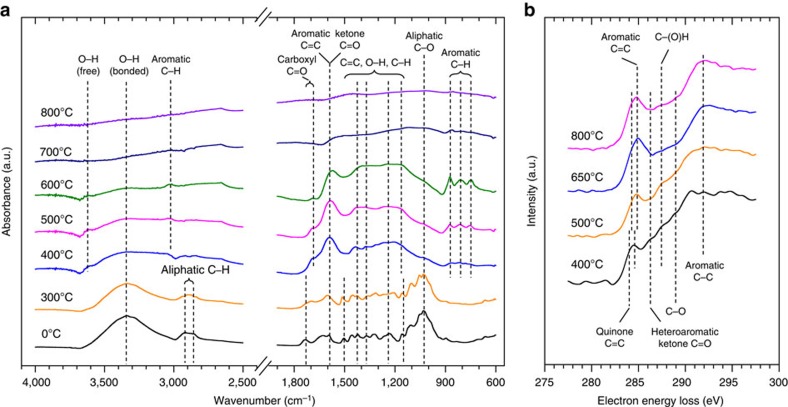
Spectroscopic examination of the surface functionality of pyrogenic carbon.(a) Fourier transform infrared (FTIR) spectroscopy of pyrogenic carbon samples pyrolysed at temperatures from 300 to 800 °C, including a non-pyrogenic wood biomass as indicated by 0 °C. (b) Electron energy loss spectroscopy (EELS) of pyrogenic carbons obtained at temperatures from 400 to 800 °C. Peaks corresponding to aromatic and quinone C=C bonds shifted to lower energy side on pyrogenic carbon produced at 400 °C than that of pyrogenic carbon produced at greater temperatures. Individual EELS spectra were recorded while scanning the electron beam over about 100 × 100 nm areas of a thin section of the pyrogenic carbons. The data presented are averages of spectra from 5 to 10 different pyrogenic carbon particles at each temperature. These are more representative than spectra from single particles. The Fourier ratio method was used to reduce the effects of multiple electron scattering on the spectra70.